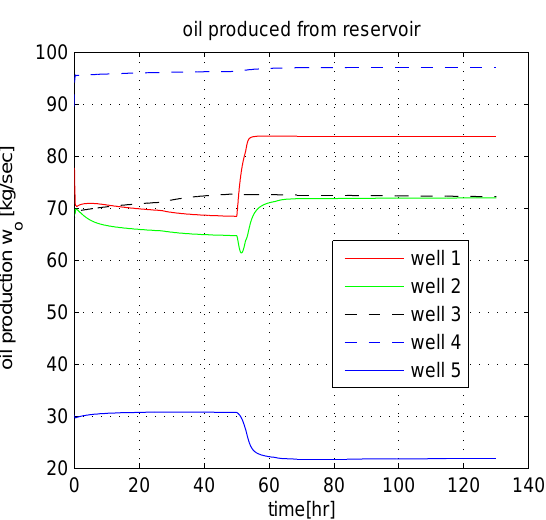
Figure 7: Lift gas distribution among wells without optimization